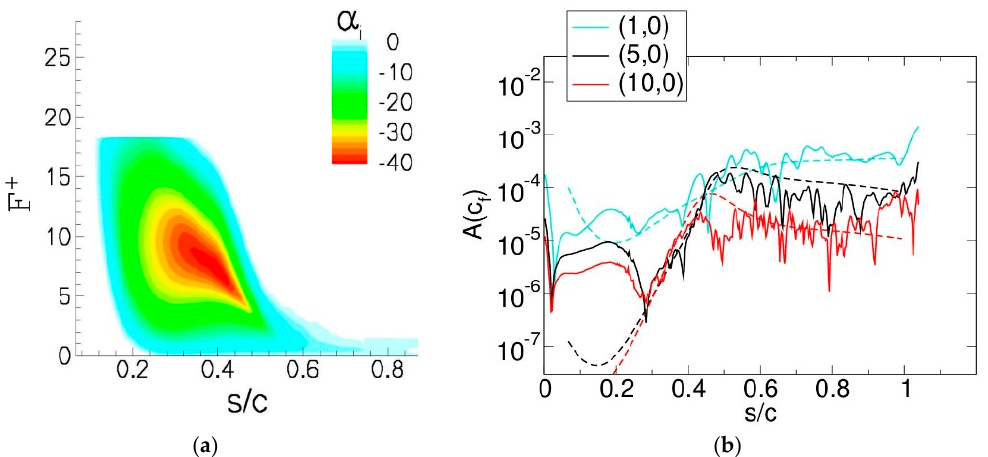
Figure 24. ( a ) Spatial growth rate (Reprinted from [31]) and ( b ) suction surface skin friction coefficient Fourier amplitudes (dashed lines: linear stability theory (LST), solid lines: simulation).